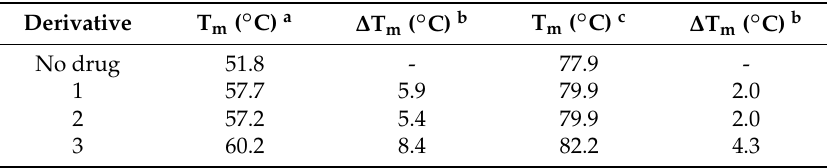
Table 3. Summary of the DNA melting